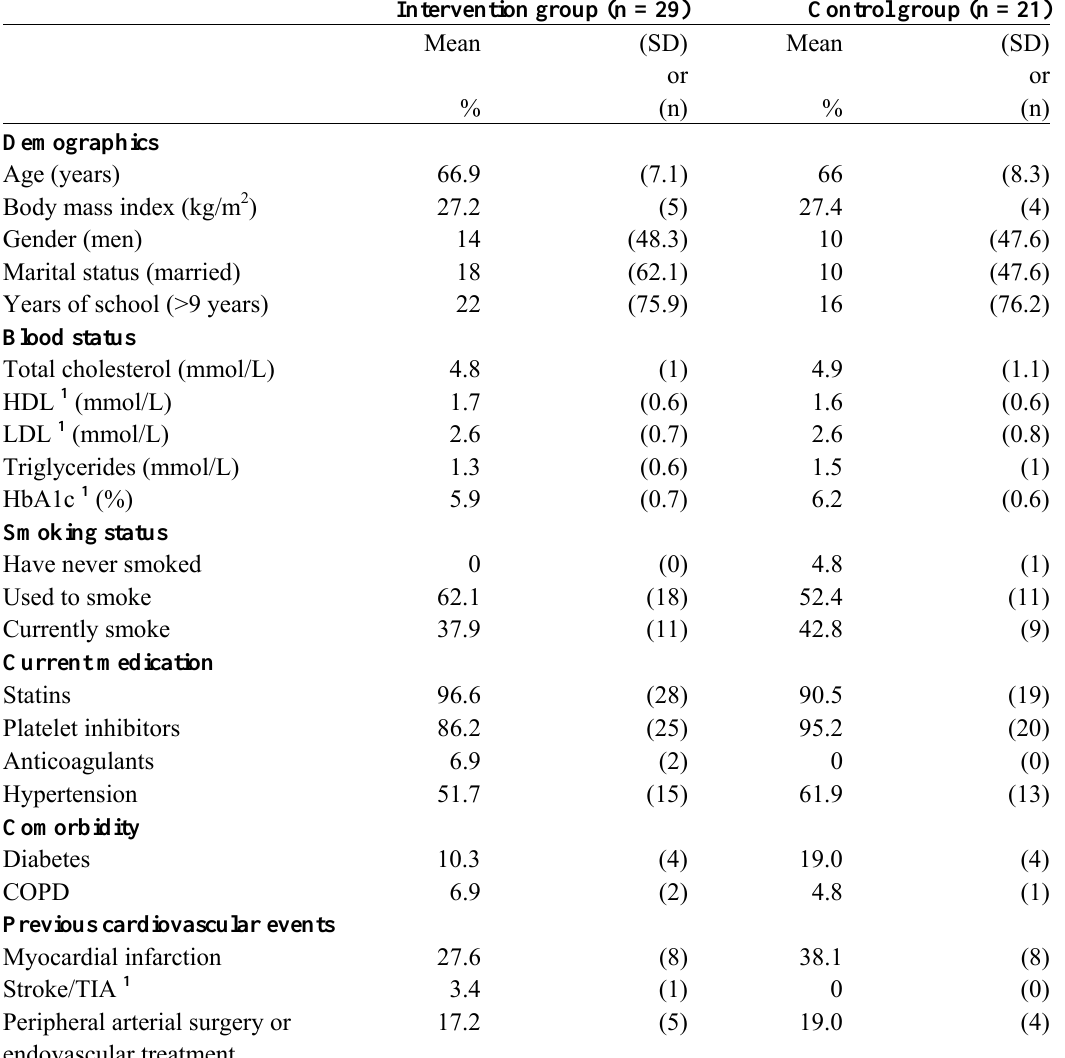
Table 1. Participant characteristics at